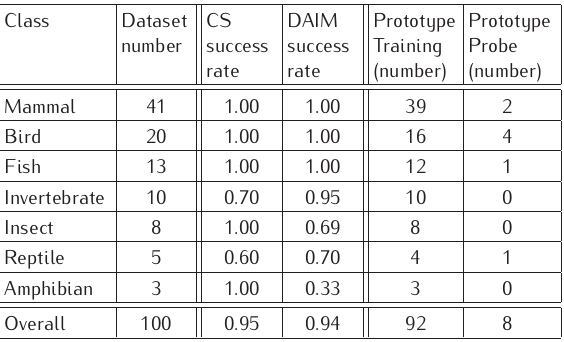
Table 1. Class distribution in the complete zoo animal dataset, the 10-fold cross-validationresultsforCSandDAIMbrokendownbyclass(classi- fication accuracy shown, two central columns); and the distribution of training and probe data used in the prototype functionality case study (two right-hand